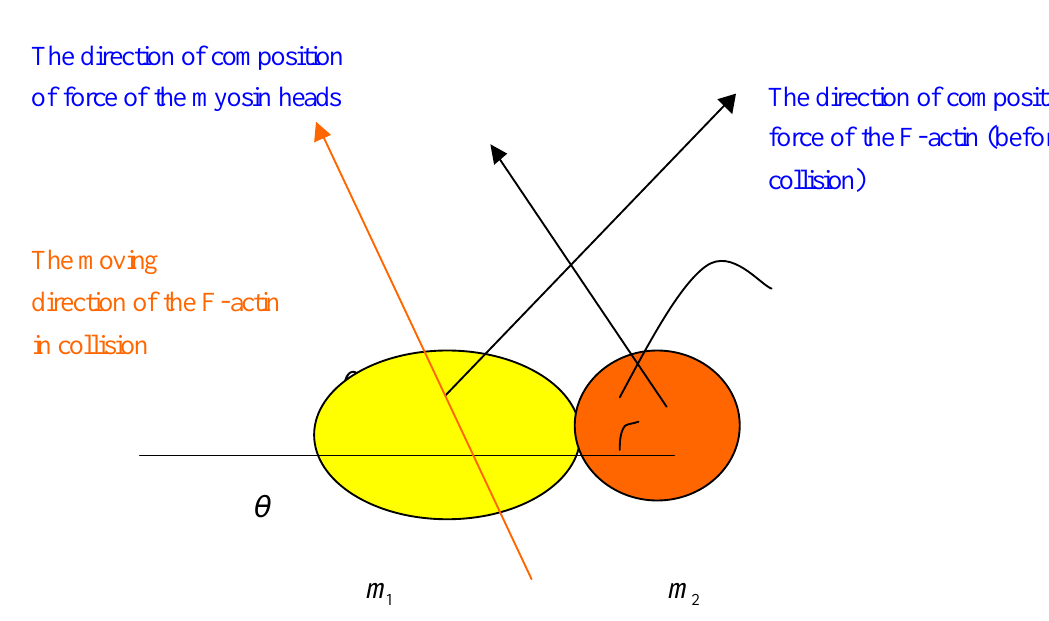
Figure 4. The state of collision on the actin-moysin